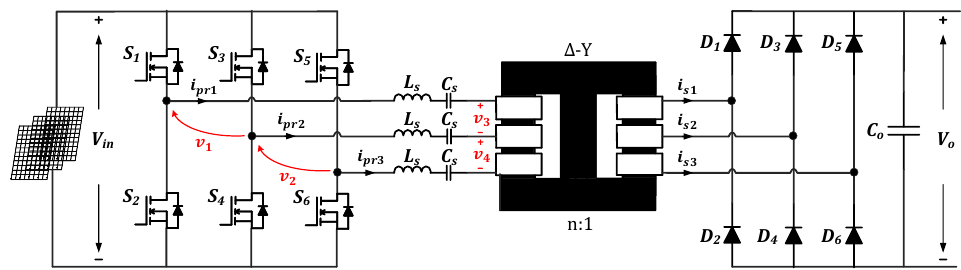
Figure 1. Circuit diagram of a three-phase series resonant converter.